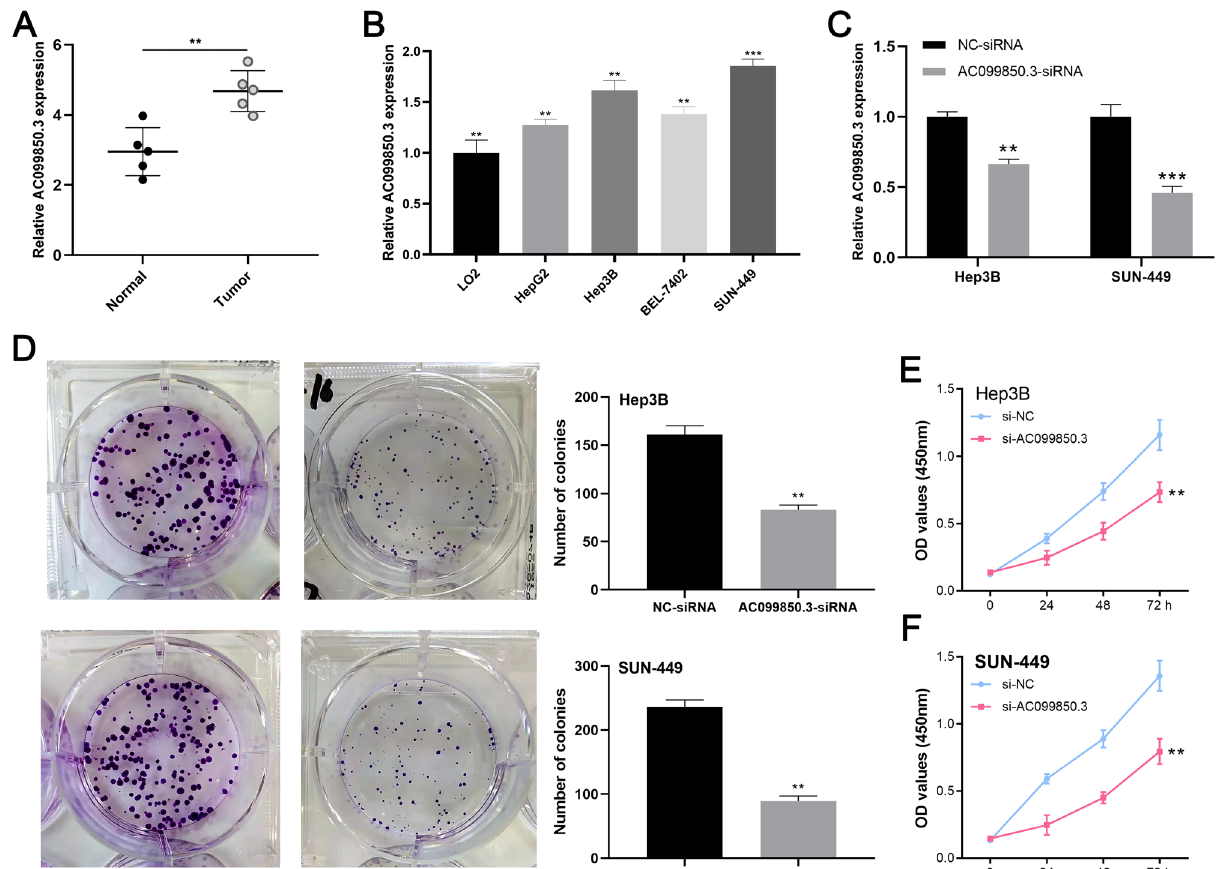
and normal hepatic cells. (C) mRNA expressions of AC099850.3 in cell lines with AC099850 knockdown. (D) Colony formation abilities of Hep3B and SUN-449 cells after AC099850.3 knockdown. Results of CCK8 assay for Hep3B (E) and SUN-449 cells (F) after AC010973.2